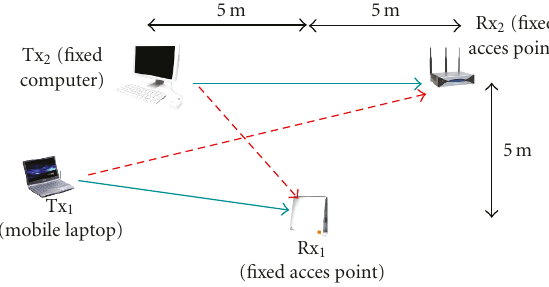
Figure 5: Assumed scenario. The network comprises one mobile laptop (Tx 1 ), one fixed computer (Tx 2 ), and two fixed access points (Rx 1 ) and (Rx 2